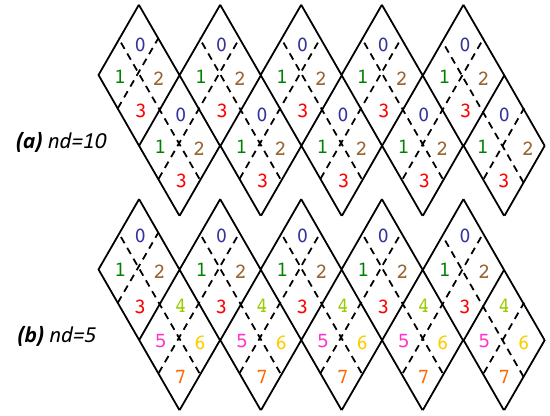
Fig. 6. Subdomain process mapping in TERRA for a case where mt / nt=2. In (a) nd=10, while in (b) nd=5. The diamonds have been projected on to a flat surface and solid black lines define their boundaries, while dashed lines represent subdomain boundaries. The number within each subdomain denotes the MPI rank of the process to which the subdomain is